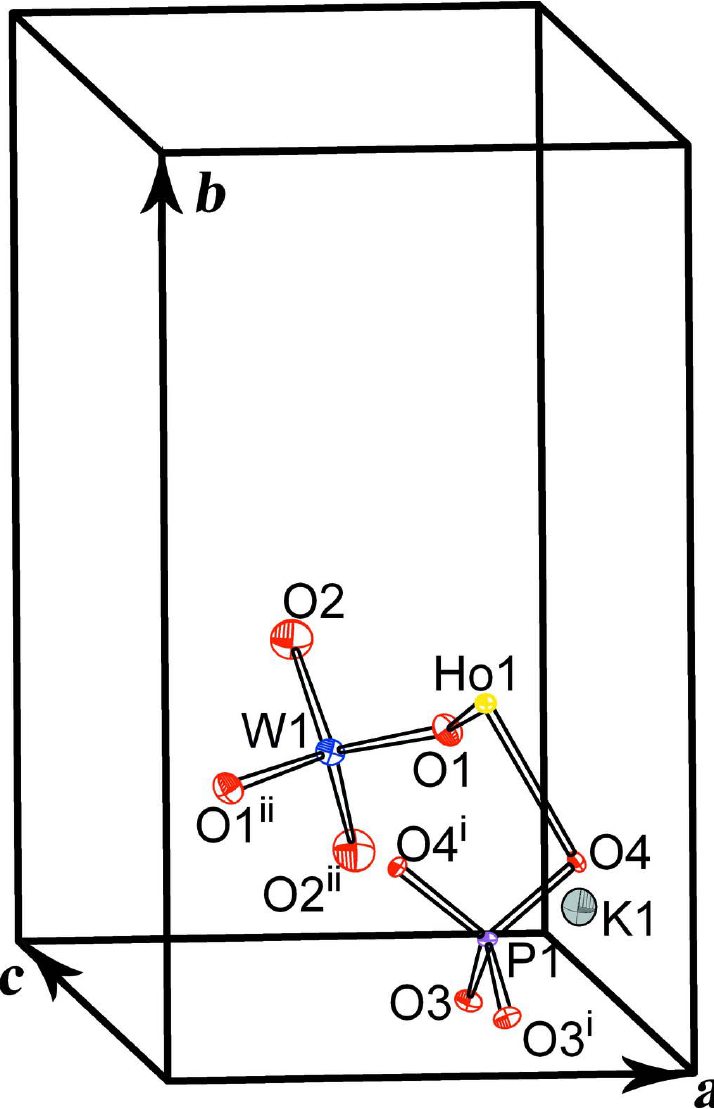
Ho(PO )(WO ) with displacement ellipsoids drawn at the 50% probability level. [Symmetry codes: (i) 1,5-x; View of K 2 4 4 y; 1-z; (ii) 1-x; 0.5-y;